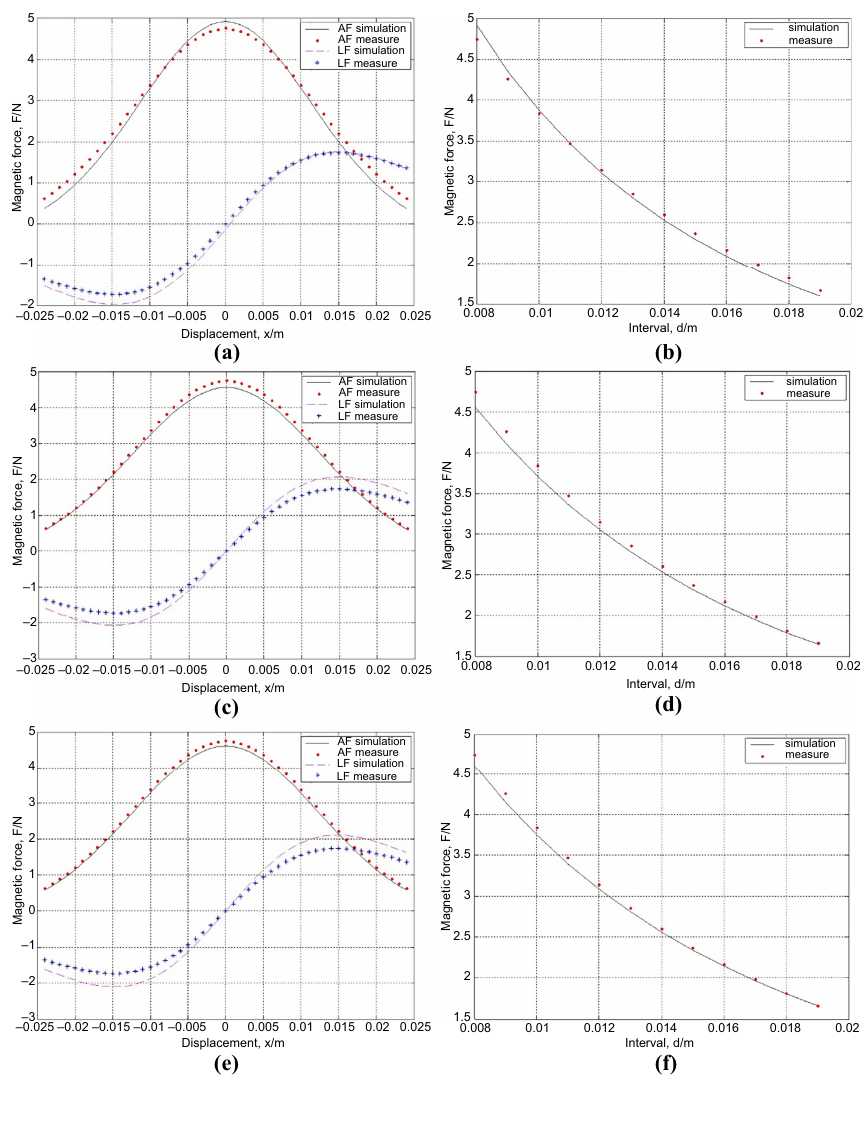
Figure 20. Comparison of simulation results based on (a) – (b) magnetizing current model, (c) – (d) magnetic charge model and (e) – (f) magnetic dipole – dipole model with the experiment data,